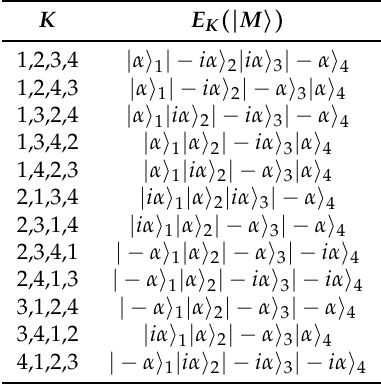
Table 3. Encryption results based on different secret keys in the case of | M (cid:105) = | α (cid:105) 1 | − i α (cid:105) 2 | i α (cid:105) 3 | − α (cid:105) 4 .